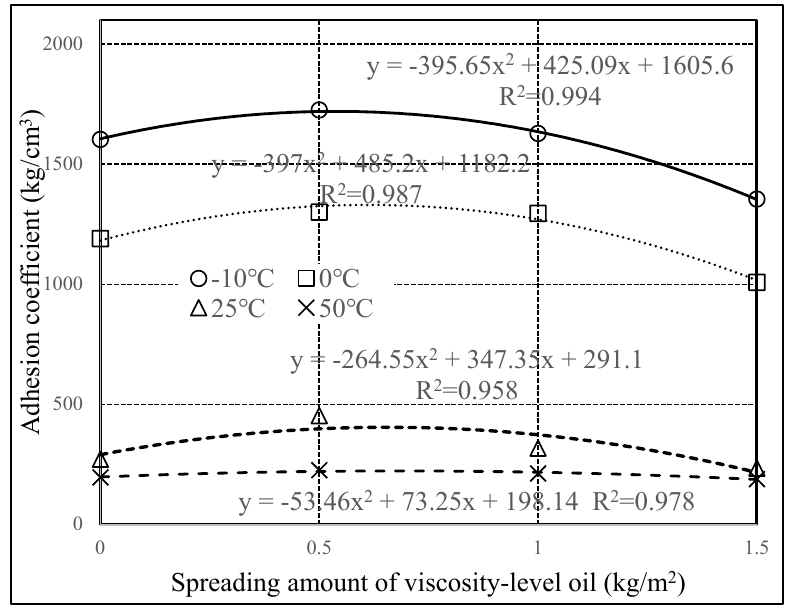
Figure 11. The curves relating spreading amount of viscosity-level oil A and adhesion coefficient.